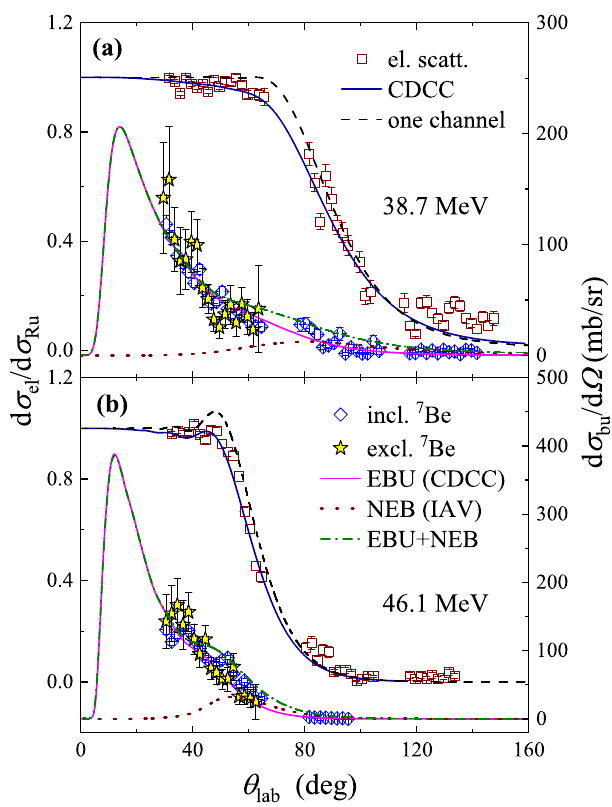
Fig. 2 | Angular distributions of elastic scattering and breakup reactions. Squares, diamonds and stars denote the experimental data of elastic scattering, inclusive and exclusive breakup at a 38.7 and b 46.1MeV, respectively. The elastic scattering and breakup data are respectively related to the left and right axes. The error bars indicate the statistical uncertainties. CDCC results for elastic scattering and elastic breakup (EBU) are shown by the blue and magenta solid curves, respectively. As a comparison, the one-channel calculations for the elastic scat- tering are represented by the dashed curves. The dotted lines correspond to the non-elastic breakup (NEB) contributions, which are derived from the IAV model calculations. The dash-dotted lines stand for the sum of EBU and